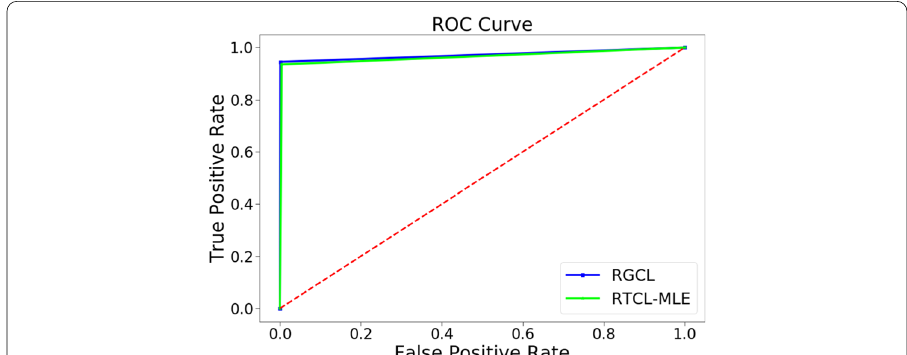
Fig. 13 ROC curves with 2 vehicles under GPS location spoofing attack